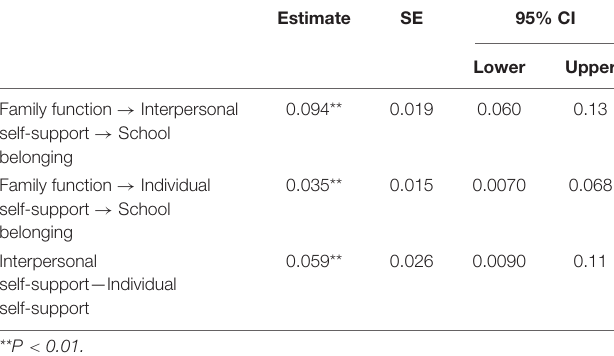
Estimate SE 95% CI Lower Upper